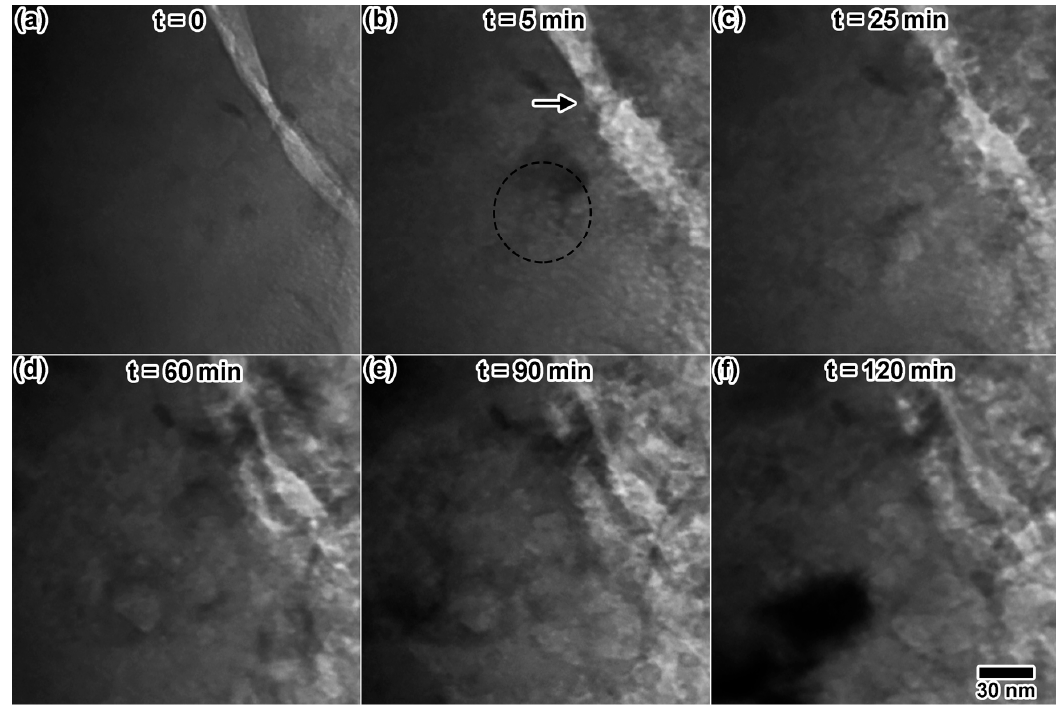
Figure 13. In situ TEM images showing microstructural evolution of LiAlO 2 under triple ion irradiation with the electron beam on the sample. ( a ) The initial microstructure appears void-free, but ( b ) cavity-like structures appear after 5 min and continue to grow in ( c , d ) until large blisters appear to crack the microstructure in ( e , f ). Dashed circles indicate a region containing easily-visible defects believed to be cavities. All TEM images were taken at the same magnification.